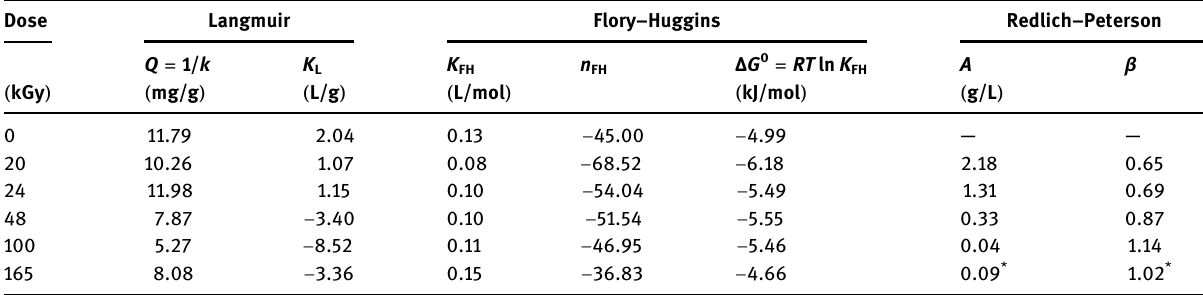
Table 5: Parameters calculated for Cu - fi tting and quasi - fi tting * models for T = 293 K Dose Langmuir Flory –